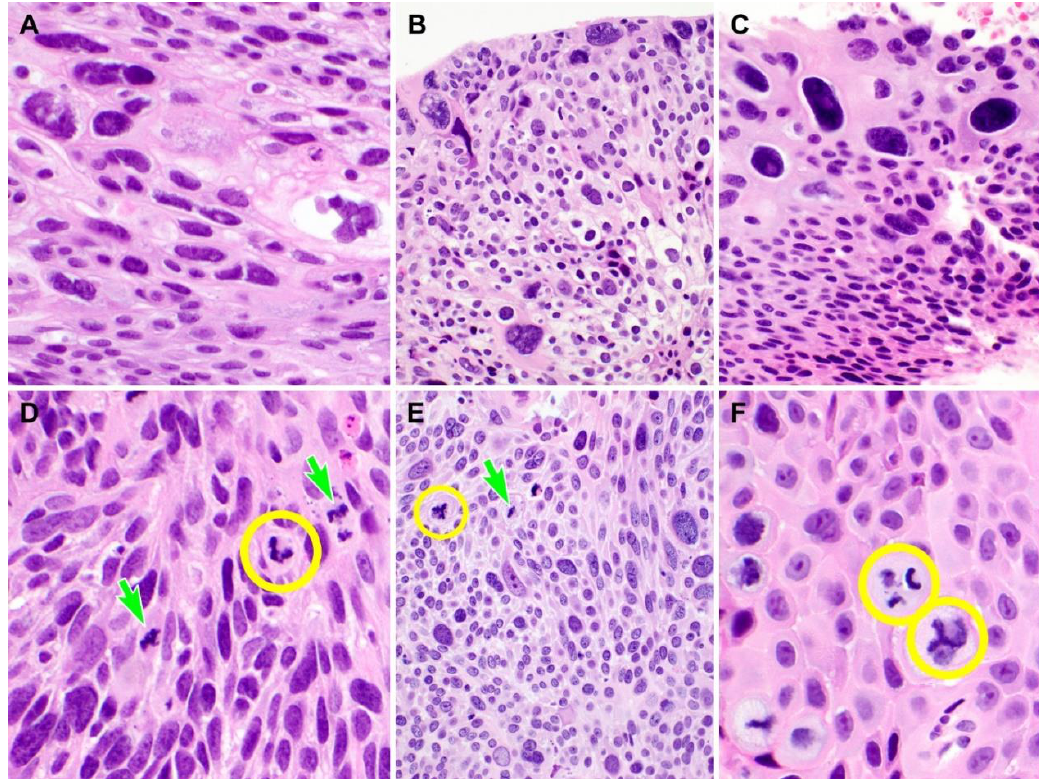
Figure 4. Difference in mitotic activity according to the microanatomical distribution of pleomorphic high-grade squamous intraepithelial lesion (PHSIL). ( A – C ) PHSILs involving the surface epithelium only show minimal or no mitotic activity. ( D – F ) PHSILs involving the endocervical glands show frequent typical mitoses (three light green arrows). Atypical mitotic figures (four yellow circles), such as asymmetric and tripolar mitoses, were noted. Hematoxylin and eosin staining. Original magnification: ( A ) = 400×, ( B ) = 200×, ( C ) = 400×, ( D ) = 600×, ( E ) = 200×, ( F ) = 600×.